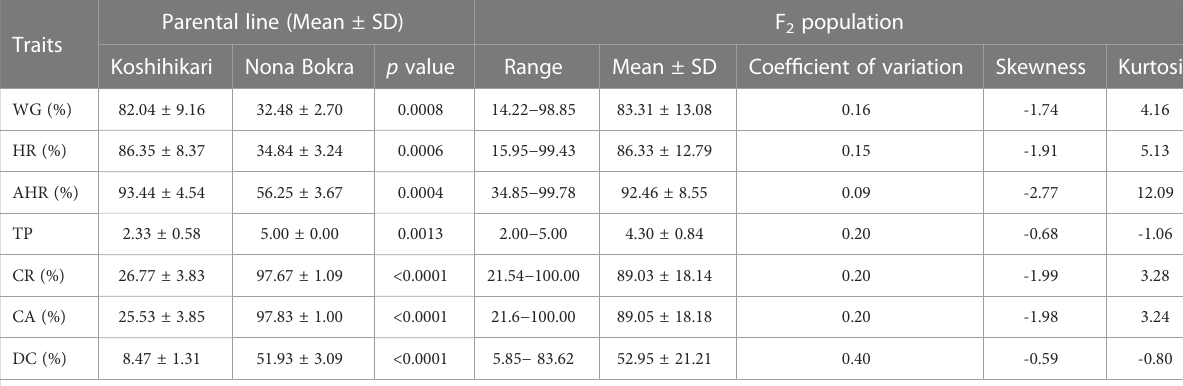
TABLE 1 Description of the grain quality traits of the two parental lines and the F 2 population.